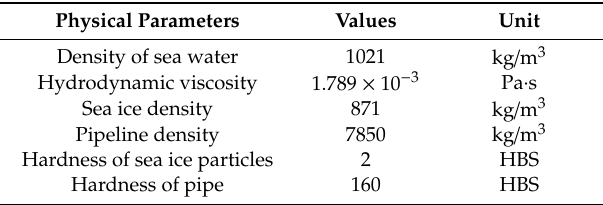
Table 1. Related parameters of two-phase flow.